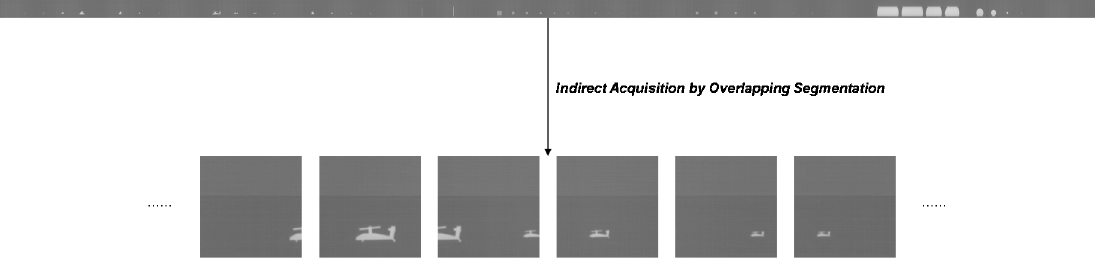
Figure 3. The indirect acquisition of sub ‐ frame images by overlapping segmentation. One target is complete in at least one sub ‐ frame image.